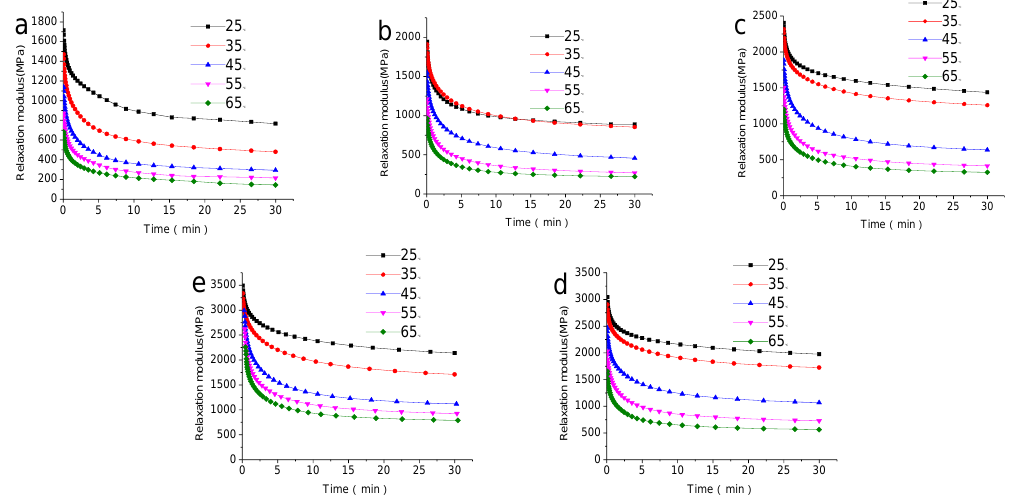
Figure 6. Effects of temperature on stress relaxation of different composites: ( a ) biochar-30 wt %; ( b ) biochar-40 wt %; ( c ) biochar-50 wt %; ( d ) biochar-60 wt % and ( e ) biochar-70 wt %.